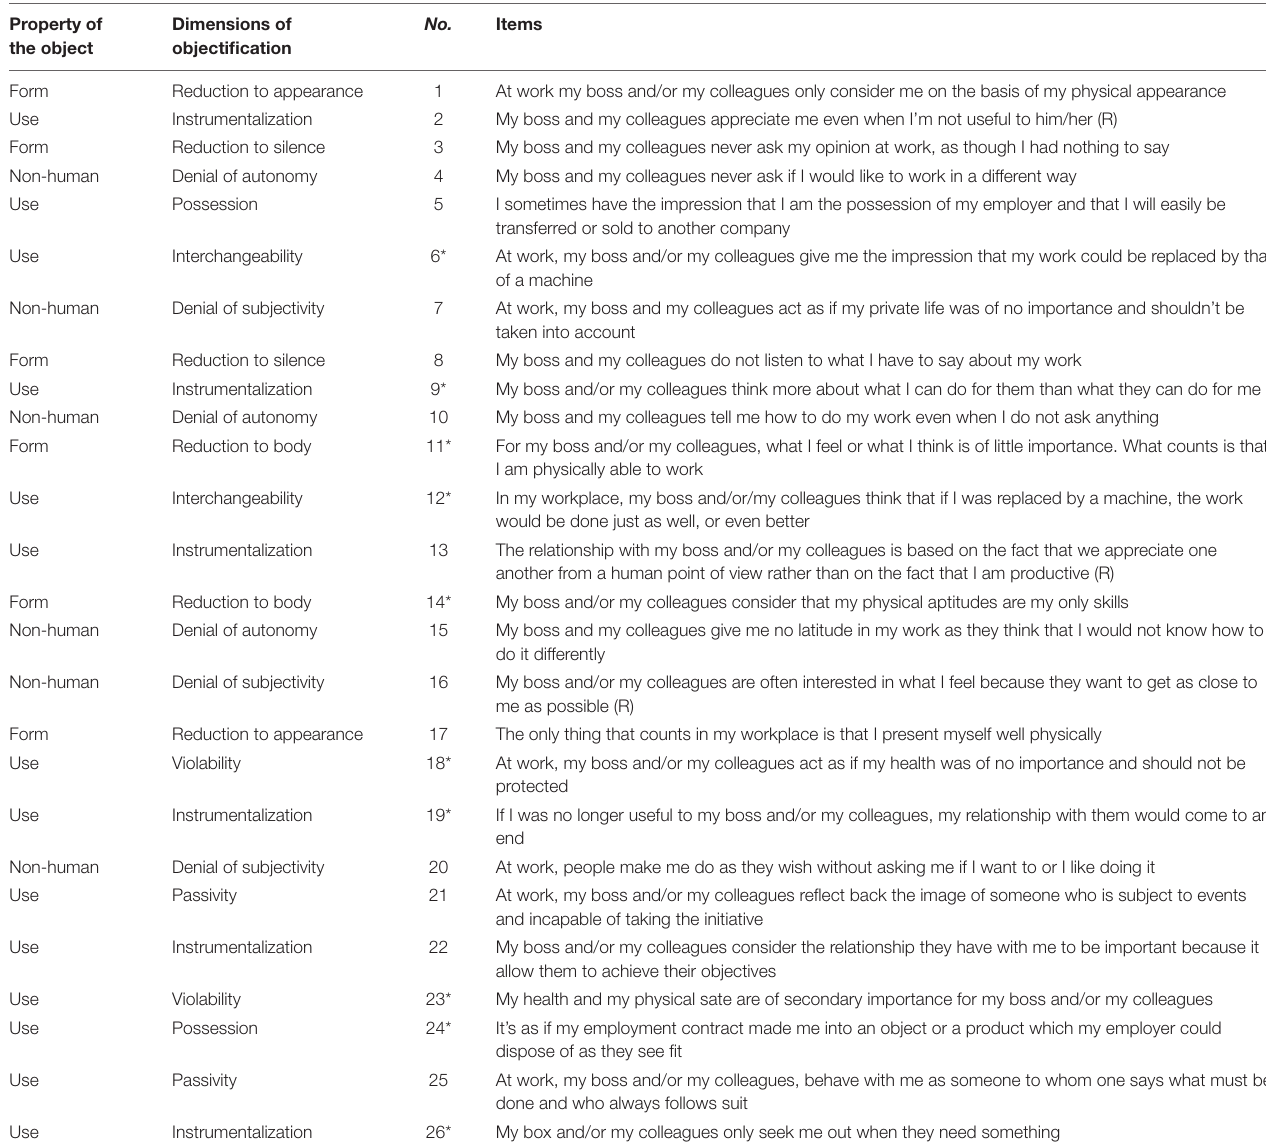
TABLE 1 | List of Auzoult and Personnar scale items with their associated dimensions: Instumentalization, passivity, possession, violability, interchangeability, reduction to silence, reduction in appearance, reduction to body, denial of subjectivity, and denial of autonomy. Property of Dimensions of No. the object objectification